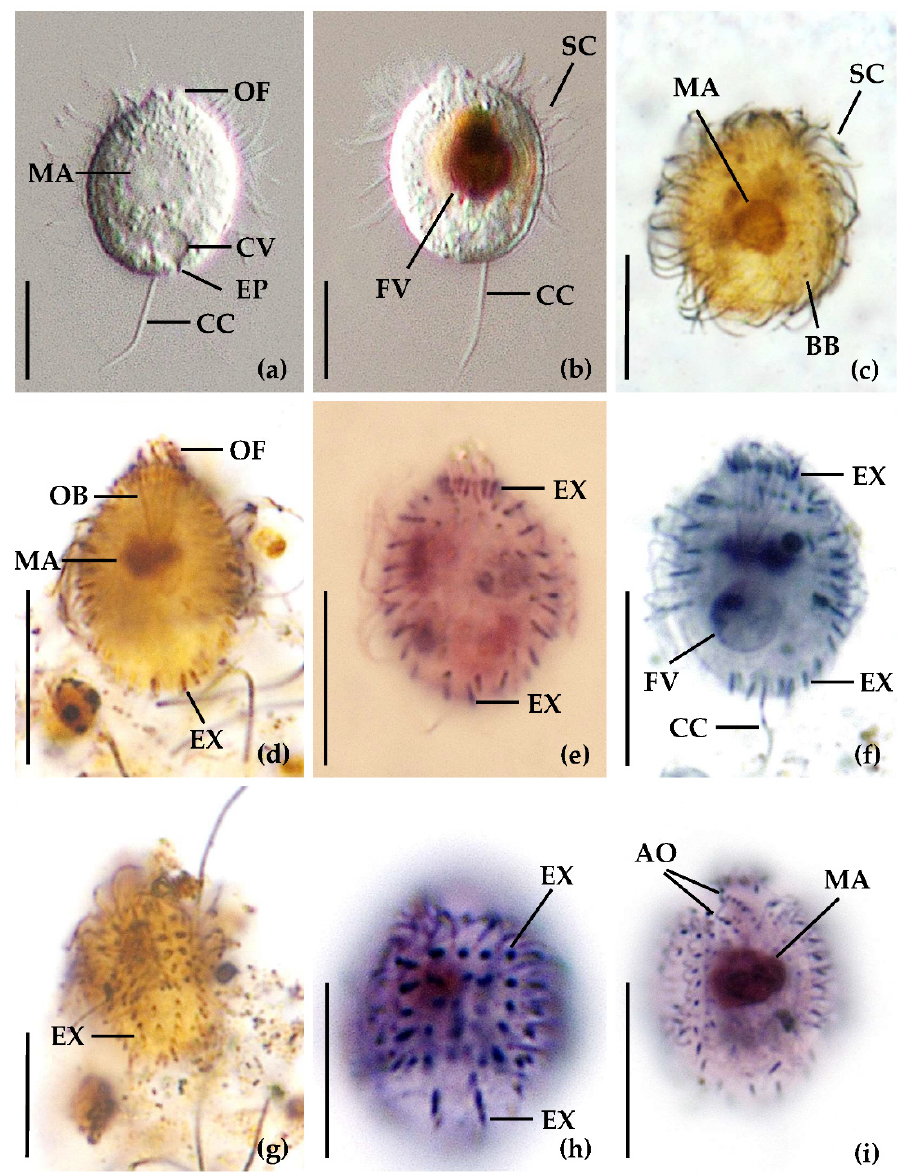
Figure 1. Species tentatively assigned to Urotricha nais from Lake Faselfad ( a – c ) and Urotricha globosa from Lake Hairlach ( d – i ) in vivo from the non-clonal original culture ( a , b ) and after protargol staining ( c – i ). ( a – i ) Longitudinal optical sections. ( e – h ) Extrusomes are aligned along the ciliary rows around mid-cell and in the unciliated posterior portion in characteristic vertical rows. ( g , h ) Specific extrusomes are arranged around the anterior part of the oral basket ( e , f ). ( i ) Details of the